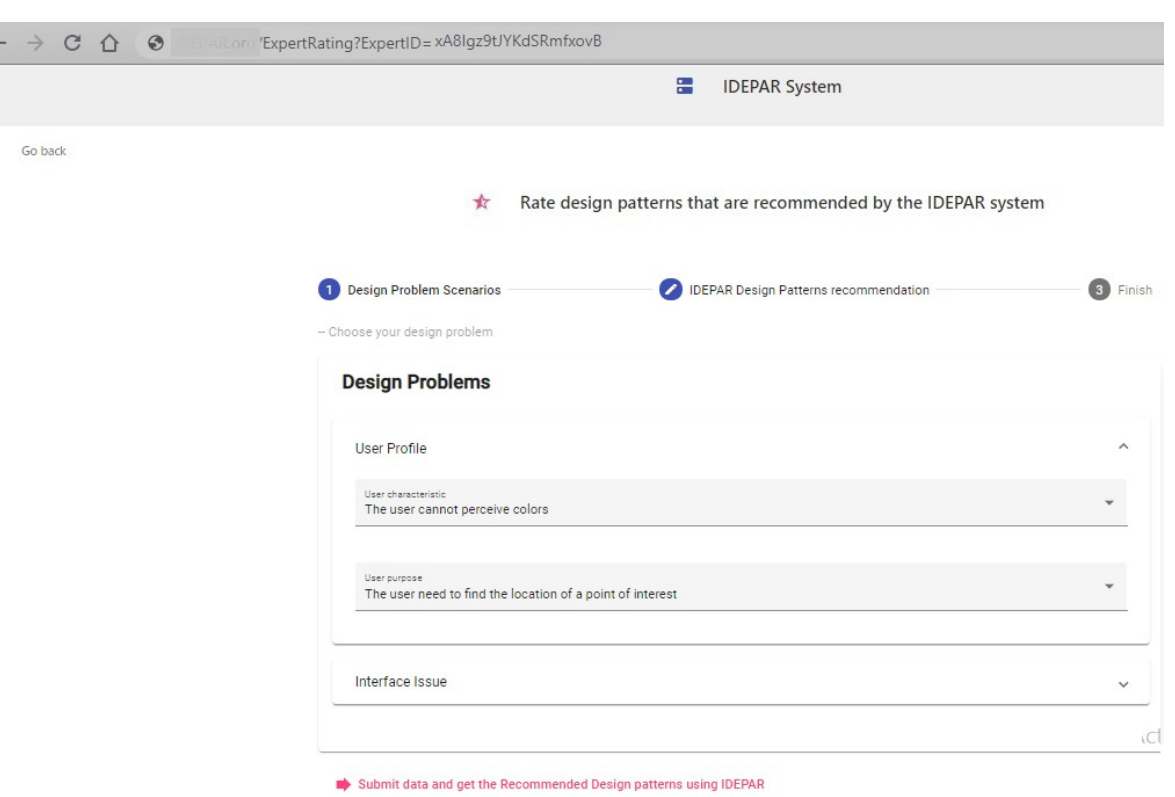
Figure 15. List of recommended design patterns for DPS-1. Second, to solve the design problem (DPS-2), Figure 16 outlines the interface for choosing DPS-2 using the user characteristic option, and Figure 17 presents the list of HCI design patterns that are recommended by the IDEPAR system to solve DPS-2. Each design